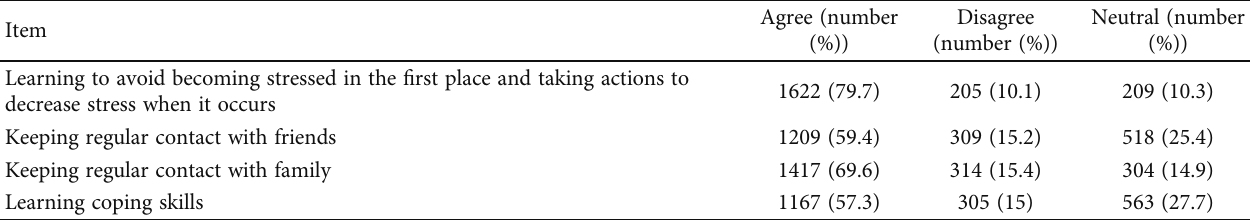
Table 2: Adolescent ’ s beliefs and knowledge about the items would reduce the risk of developing a problem like a vignette.